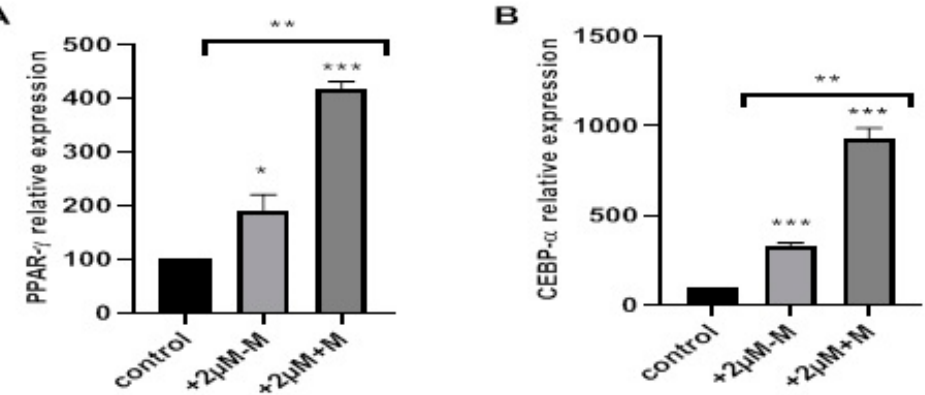
Figure 3. Effects of rosiglitazone on gene expression of PPAR- γ and C/EBP- α in mature adipocytes. Mesenchymal stromal cells were treated without ( − ) (control) or with (+) 2 µ M rosiglitazone in both induction and maintenance media (+2 µ M+M) or only in induction media (+2 µ M-M) prior to RNA extraction. Extracted RNA was used for expression studies. The representative statistical data of ( A ) PPAR- γ and ( B ) C/EBP- α gene expression were normalized to GAPDH gene and are presented as mean ± S.E.M. * p < 0.05, ** p < 0.01, *** p < 0.001 versus control.